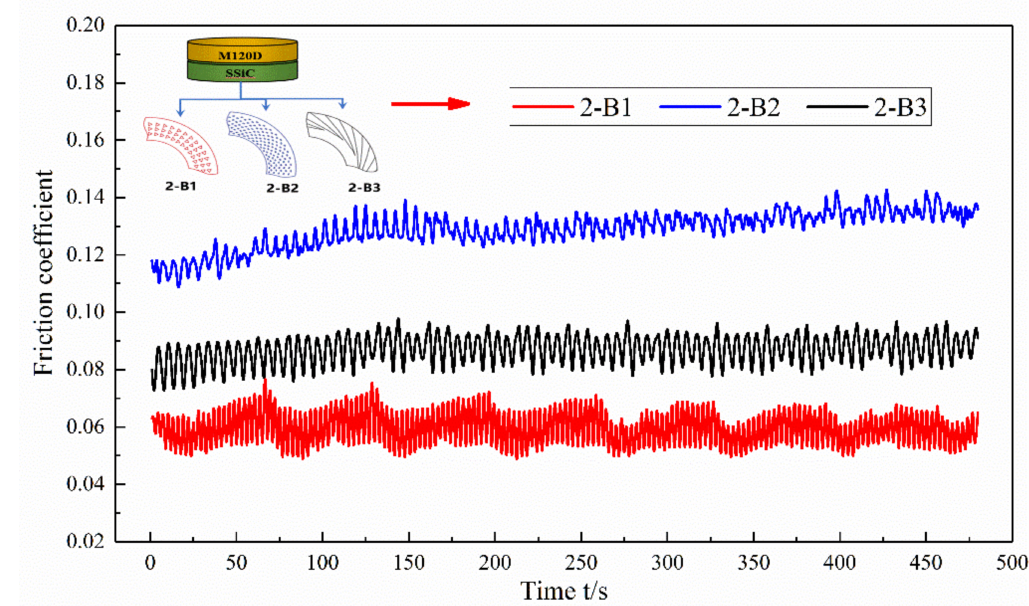
Figure 6. Real-time friction coefficient of friction pairs with single texture patterns under 250 rpm. Table 6. Data of friction coefficient and surface temperature of friction pairs for 2-B1, 2-B2, and 2-B3 groups. Load Rotating